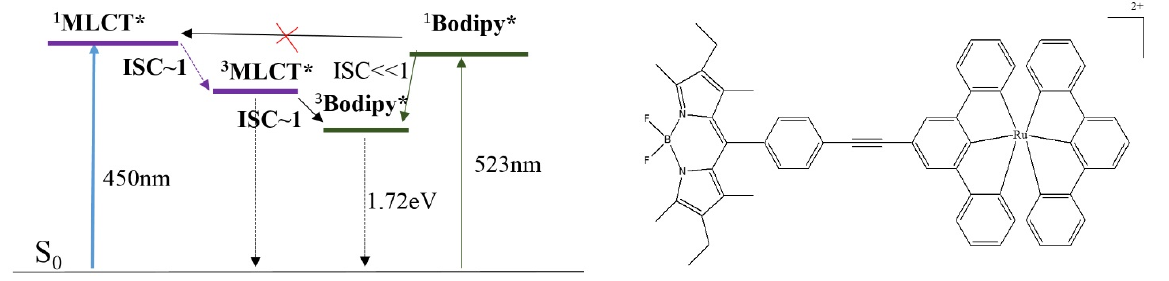
Figure 32. Energy diagram for a Ru(II) complex having BODIPY as a visible light harvesting ligand, showing energy transfer is